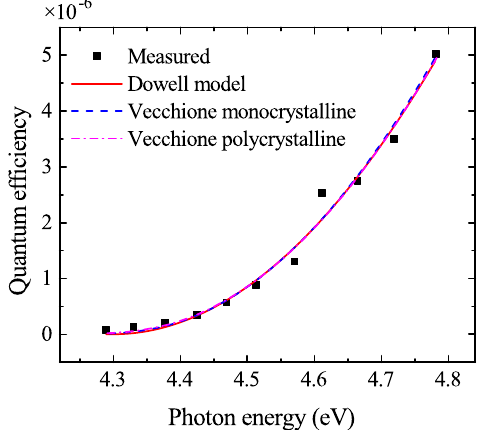
FIG. 2. Photon energy dependence of quantum efficiency. The work functions obtained from fitting with the Dowell model [13] and Vecchione monocrystalline model [35] are 4.30 and 4.31 eV, respectively. From the Vecchione polycrystalline model [35] they are 4.26 – 4.36 eV.